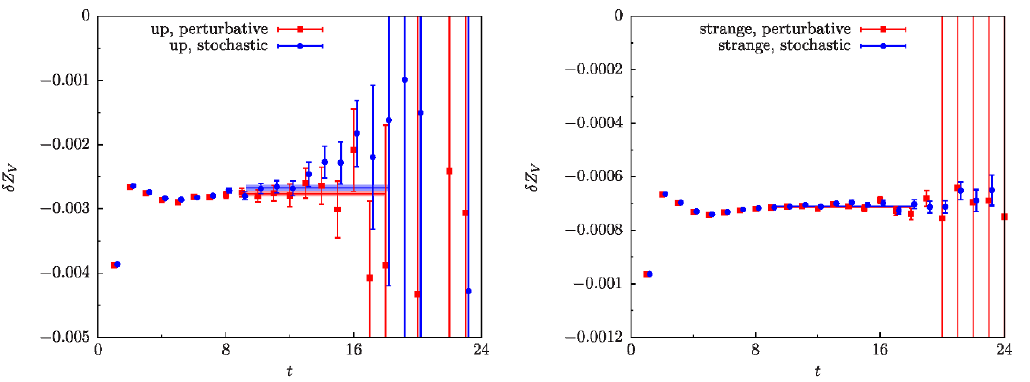
Figure 16 . The QED correction to Z V . The plot on the left shows the results of equation (5.26) for the up quark, the plot on the right for the strange quark. Red squares and blue circles denote data from the perturbative and the stochastic method, respectively.